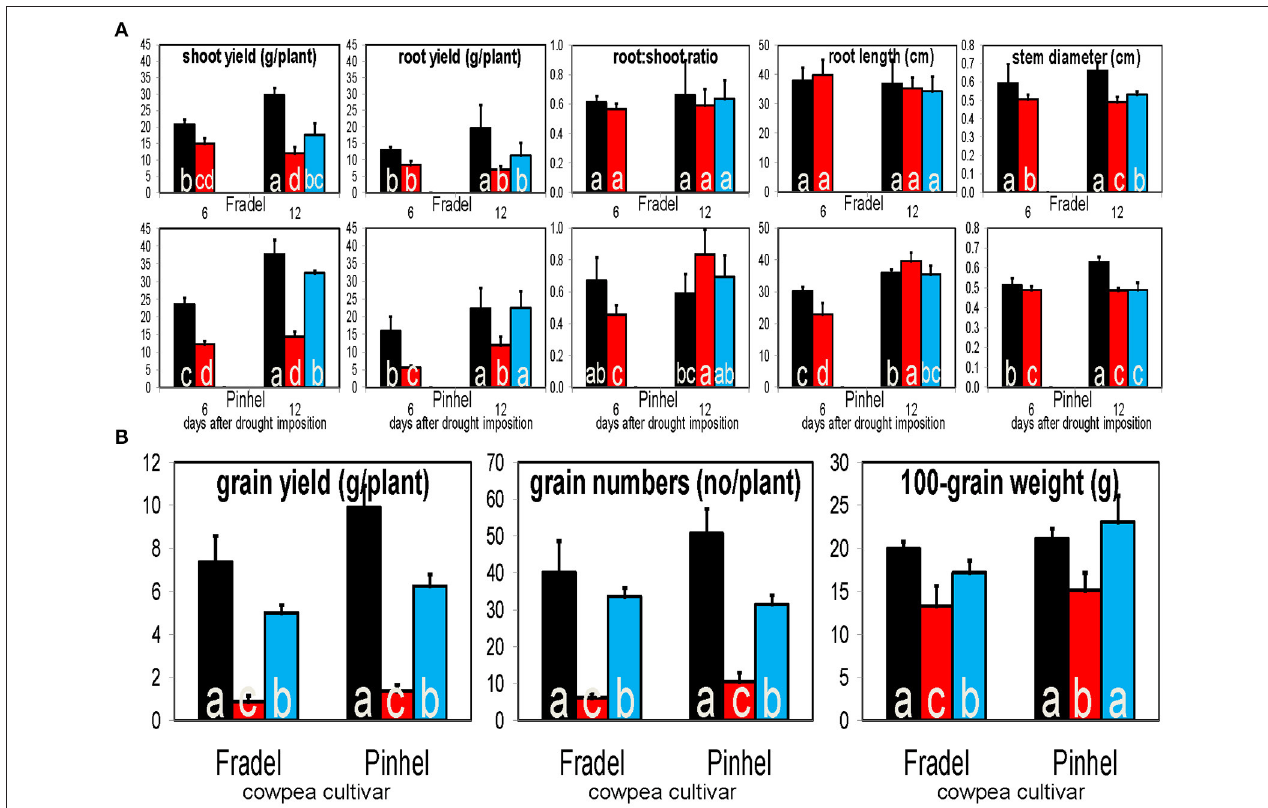
FIGURE 12 | Responses of cowpea fresh biomass, root length, and stem diameter (A), and grain yield and yield-related parameters (B) , to drought stress and rewatering. Bars indicate well-watered controls (black), drought stress for 6 or 12 days (red), and rewatering after 6 days of drought stress (blue; n = 6; error bars = SD). Different letters inside the columns for each cultivar denote statistical differences (Tukey’s test; P <